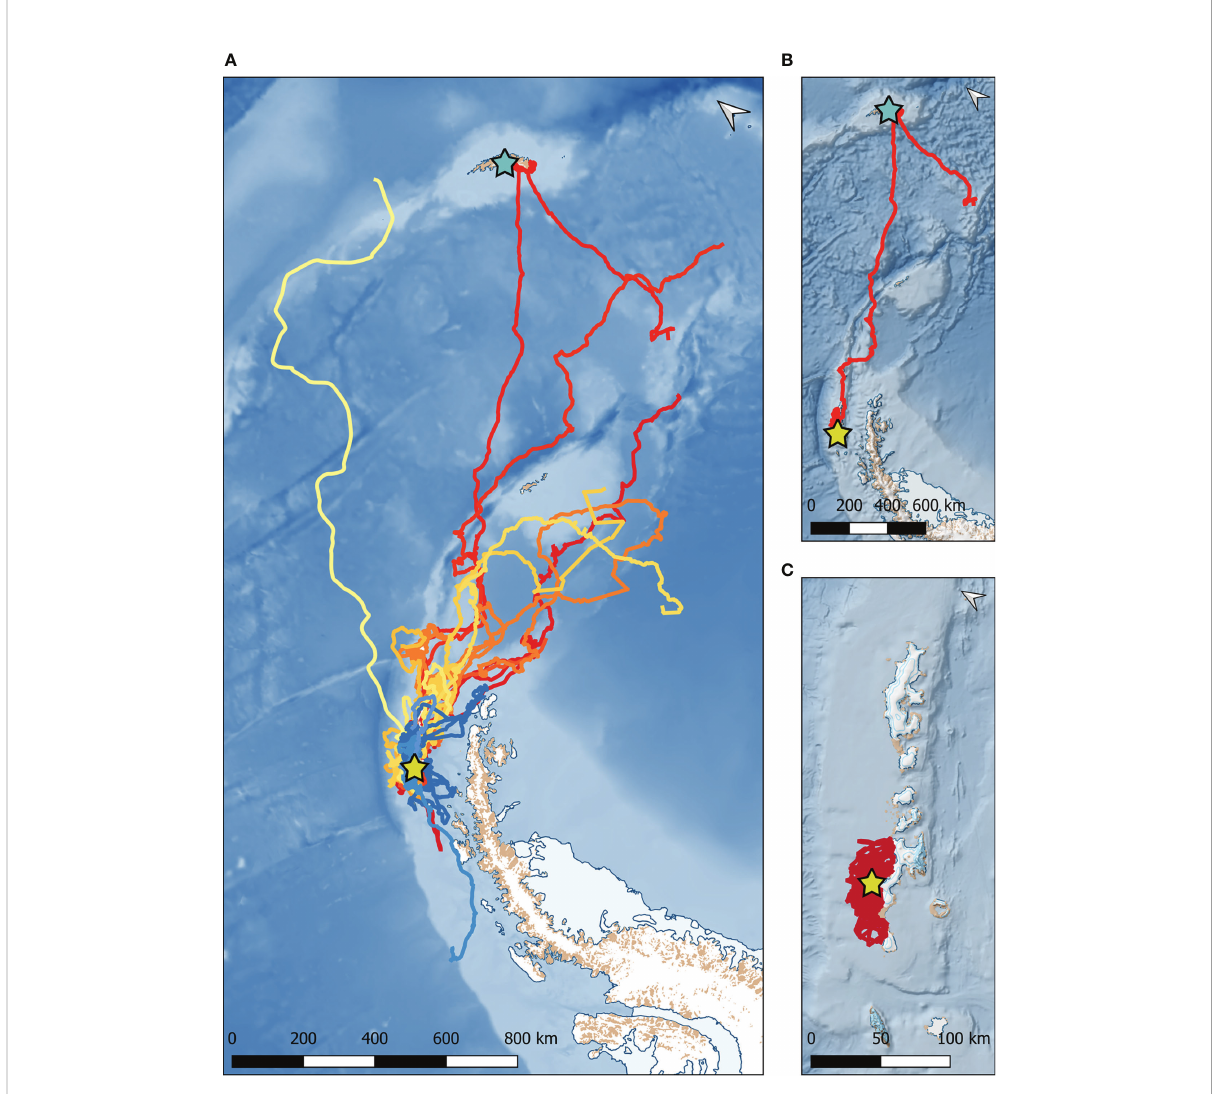
FIGURE 3 Comparison of movement patterns of leopard seals instrumented at Cape Shirreff. (A) GPS tracks of 22 leopard seals that transmitted for 139 ± 71 (mean ± standard deviation) days. Each color represents a different seal. Warm colors (reds, oranges, yellows) represent female seals. Cooler colors (blues) represent male seals. The yellow star represents Cape Shirreff. (B) GPS track of the seal (adult female #57) that traveled the farthest maximum distance (1,669 km) from Cape Shirreff to South Georgia (represented by the aqua star). (C) GPS track of the seal (adult female #128) that traveled the shortest maximum distance (46 km) from Cape